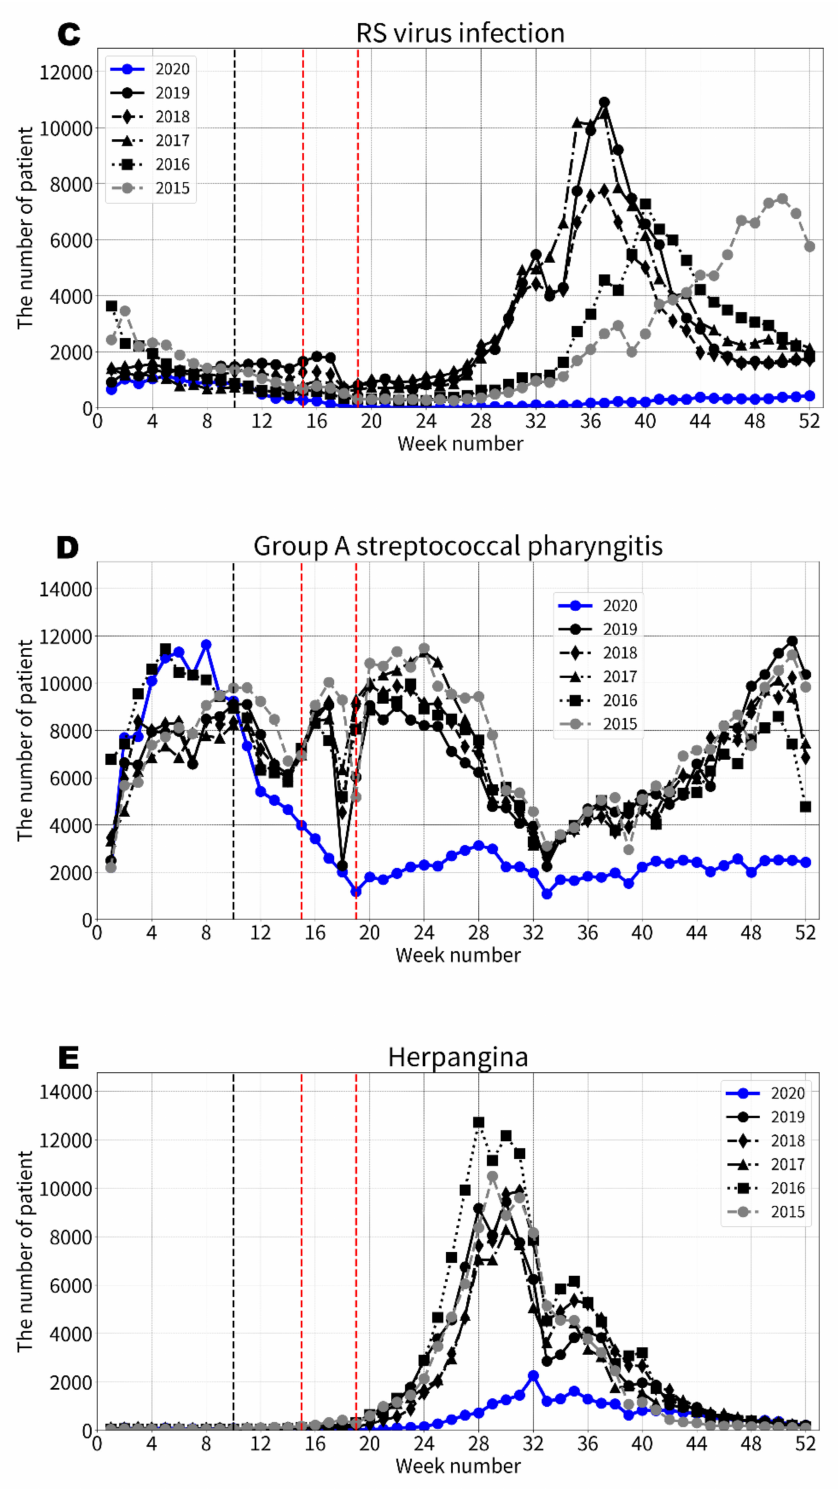
Figure 2. The weekly trends in the numbers of patients with pediatric infectious diseases in the 1- year (52-week) period. The initiation of the nationwide school closure at the 10th week is highlighted by the black dashed lines and the national State of Emergency from the 16th to 19th weeks is shown by the red dashed lines. The schools typically reopened after the State of Emergency was officially lifted in the 19th week. ( A ) Hand-foot-and-mouth disease. ( B ) Pharyngoconjunctival fever. ( C ) Respiratory syncytial virus infection. ( D ) Group A streptococcal pharyngitis. ( E )